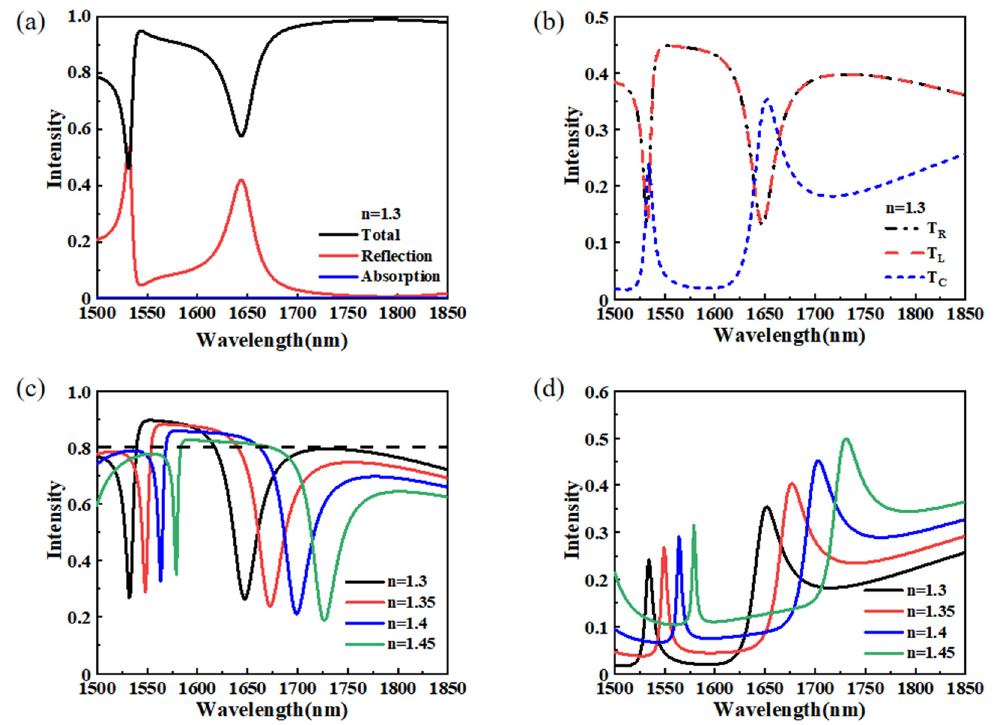
Figure 9. ( a ) Total transmission, reflection, and absorption spectra of the proposed metasurface with n = 1.3. ( b ) The intensities of T L , T R , and T C for the range of 1500–1850 nm with n = 1.3. ( c ) The anomalous transmission intensity of the proposed structure with different refractive indices. ( d ) Reflection spectra of the proposed design with different refractive indices.